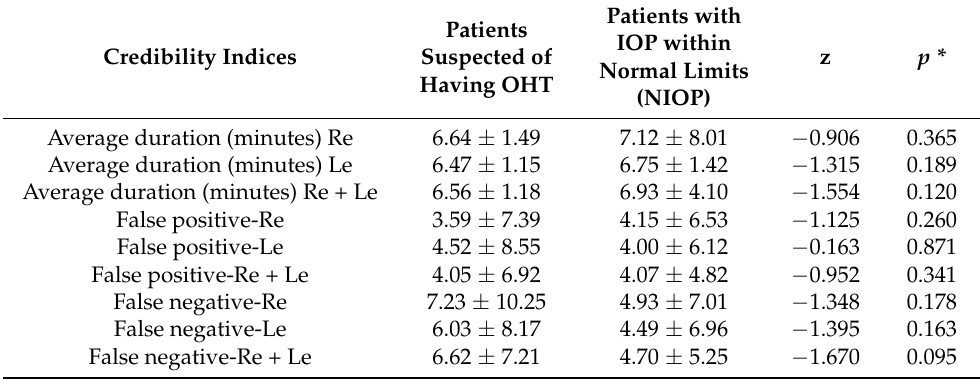
Table 4. Distribution of credibility indices in the interpretation of the “Visual Field”